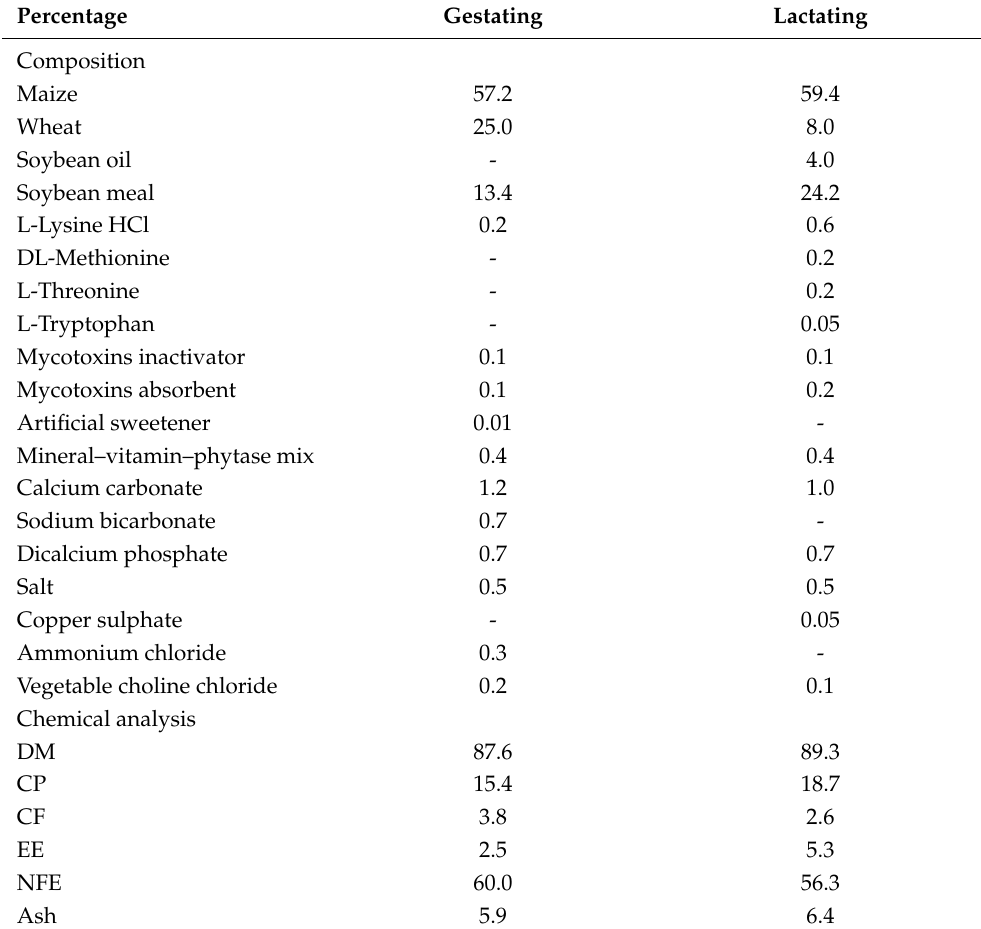
Table 1. Maternal diets